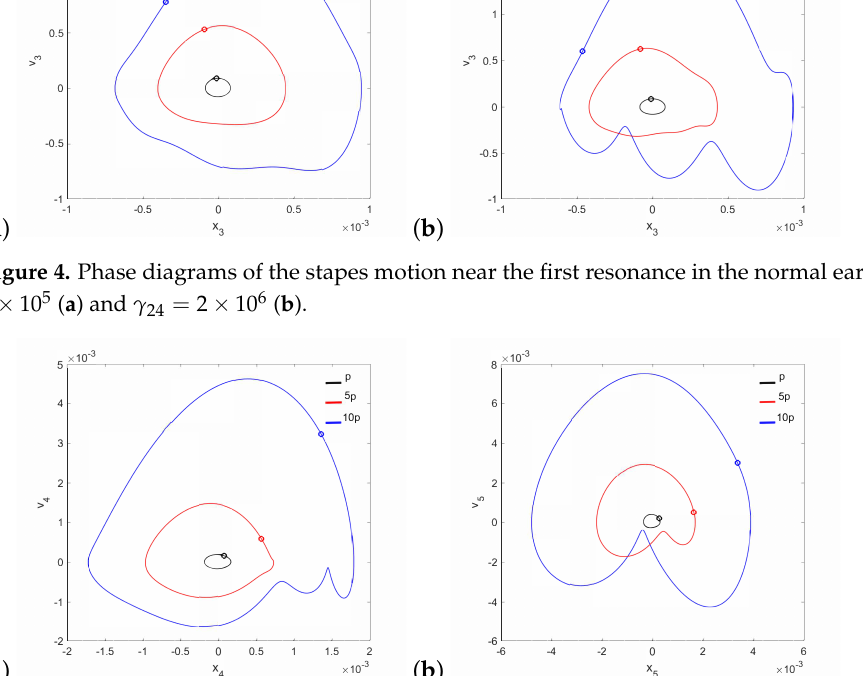
Figure 5. Phase diagrams of FMT motion near the first resonance in the normal ear for γ 24 = 1 × 10 5 : the can ( a ) and the magnet ( b